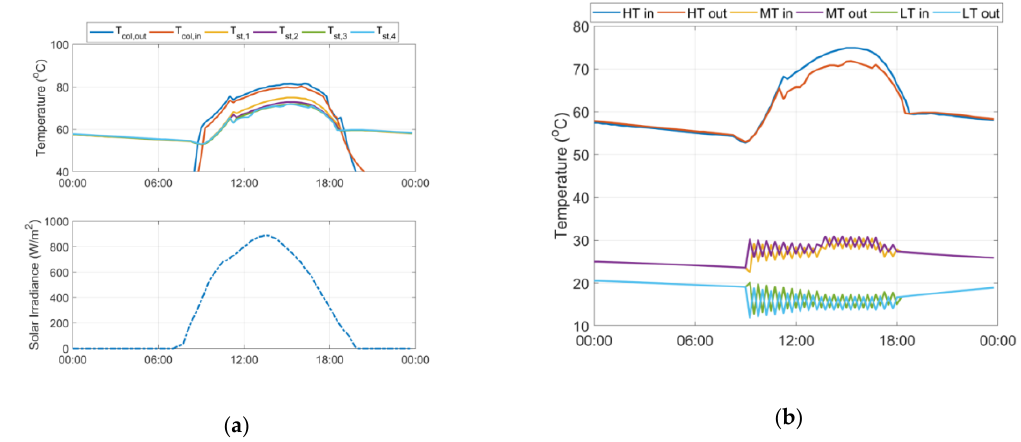
Figure 11. Overview of ( a ) the solar field temperatures and solar irradiance and ( b ) the adsorption chiller for combined operation.